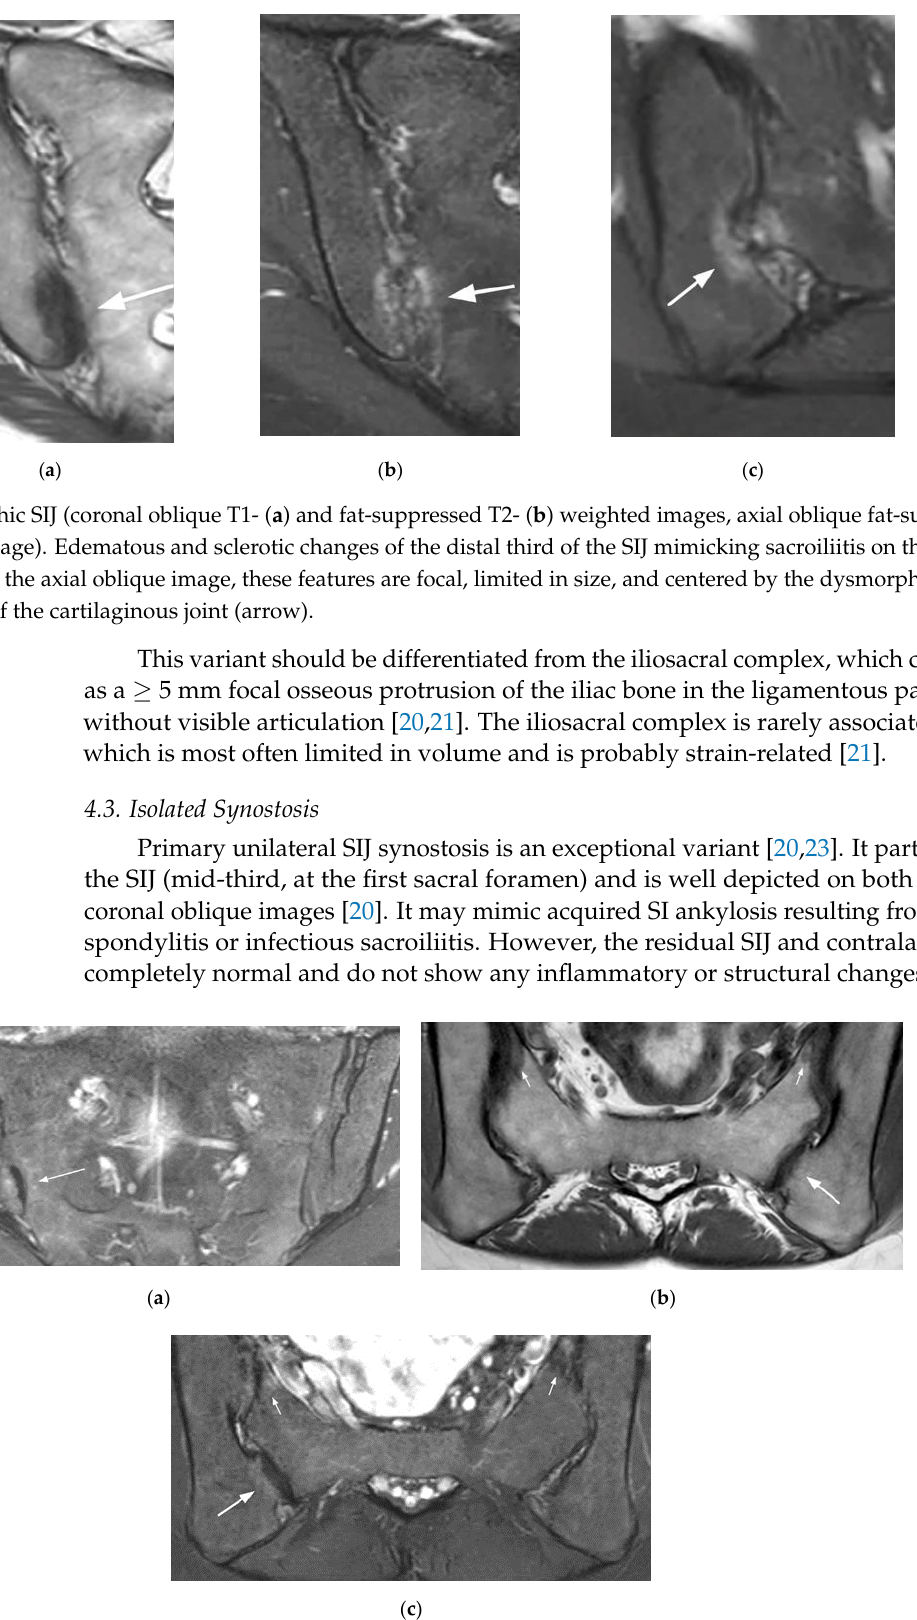
Figure 7. Right accessory SIJ (coronal oblique fat-suppressed T2- ( a ) weighted image, axial oblique T1- ( b ), and fat-suppressed T2- ( c ) weighted images). This unilateral accessory joint is mainly associated with sclerotic changes and is surrounded by a mild BME (long arrow). Note the associated mechanical changes in the SIJ (small arrows).